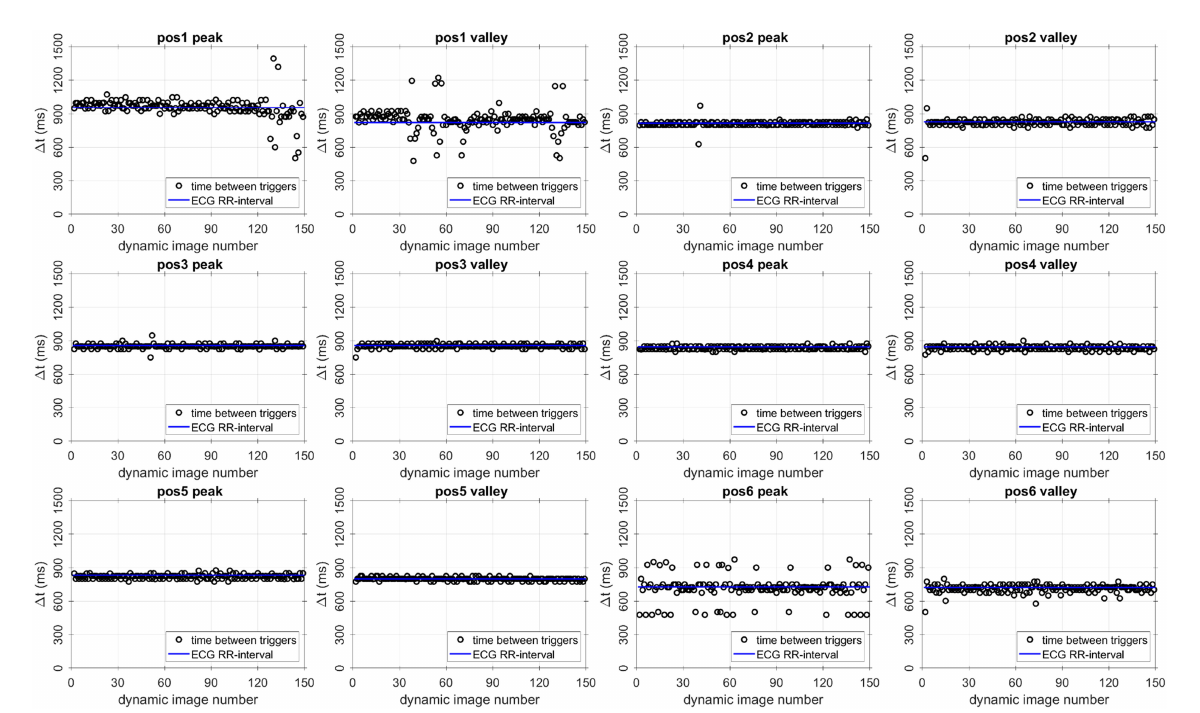
FIGURE5 Intervals between triggering events (black circles) and ECG-derived RR interval (blue lines) for all AT-triggered thermometry stability experiments. The AT-trig-derived cardiac cycle length matches the ECG-derived value well throughout the experiments. Pos, position within the LV.